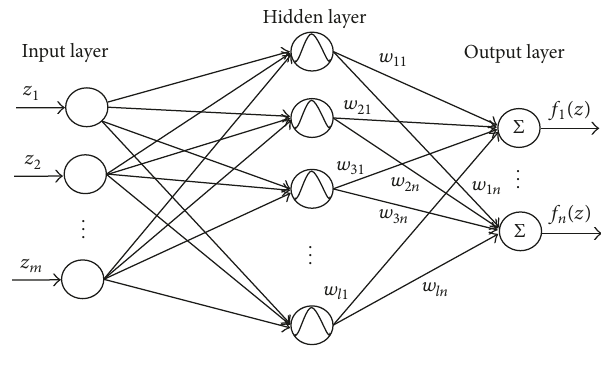
Figure 2: Structure of the RBFNN.